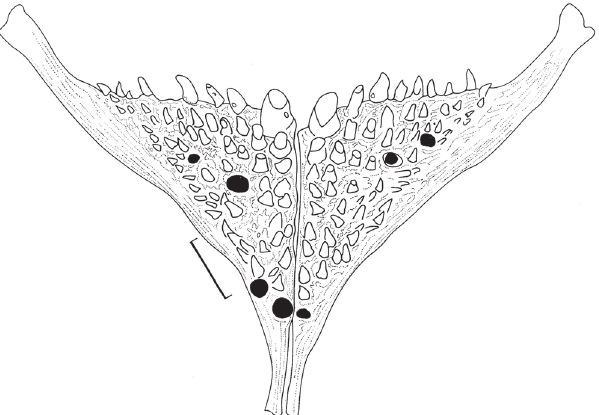
Fig. 4. Crenicichla ypo , AI 263, 95.3 mm SL, lower pharyngeal tooth plate in occlusal view. Scale bar = 1